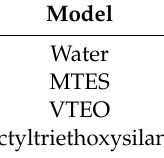
2. Number of adsorbed ions* onto